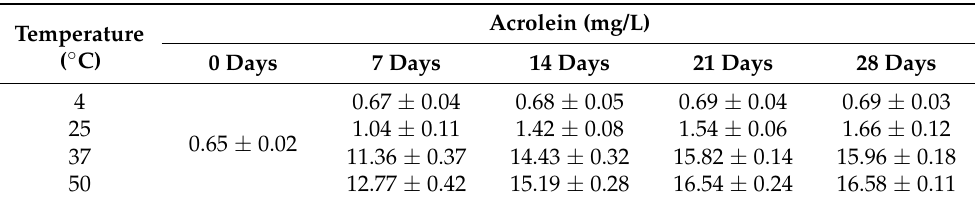
Table 3. The Effect of temperature and time on the production of acrolein from 3- hydroxypropionaldehyde in aqueous